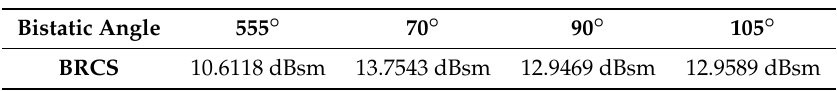
Table 9. Representative average values of the estimated BRCS of the car model selected for the study. BRCS, Bistatic Radar